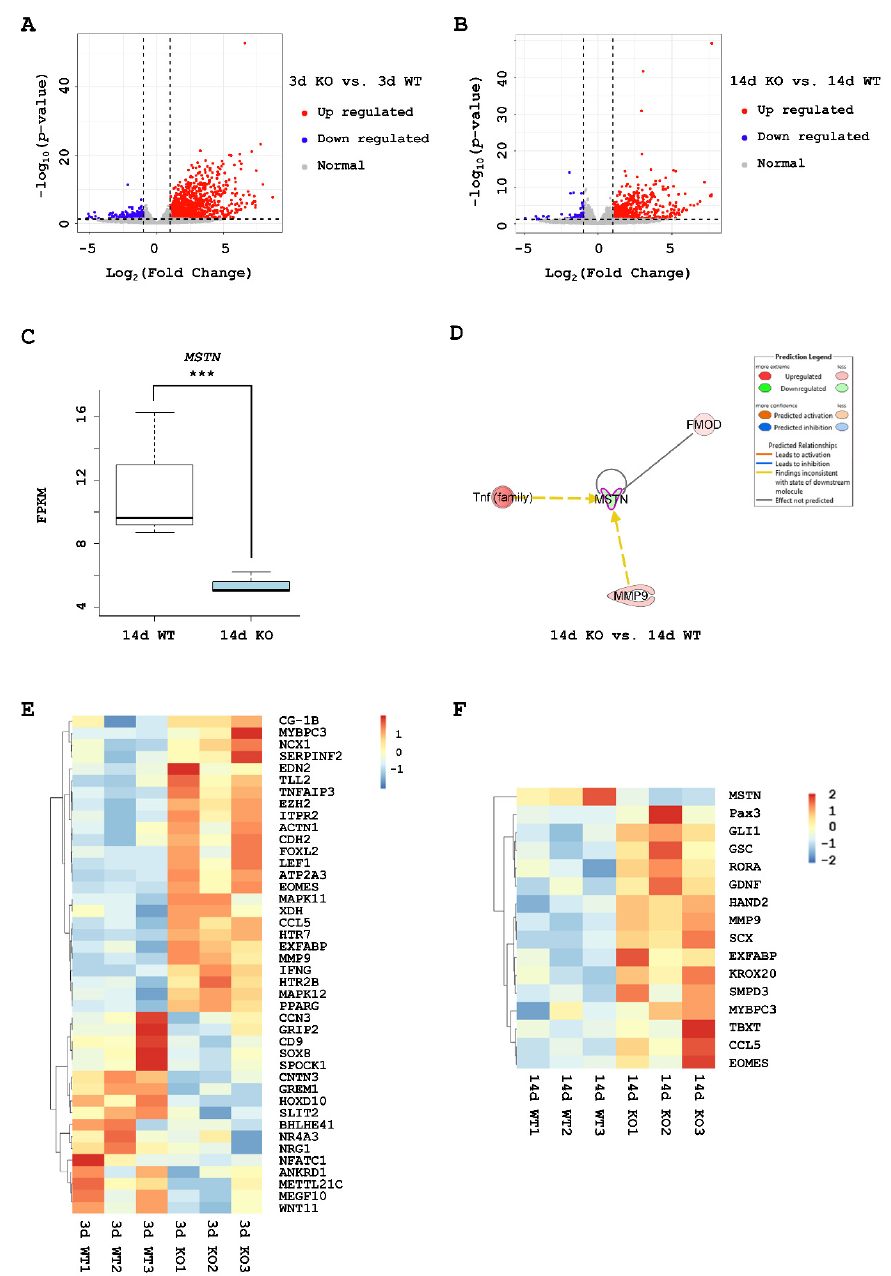
Figure 2. Di ff erentially expressed genes (DEGs) from RNA-Seq data. ( A ) Volcano plot reveals significant di ff erentially expressed genes in the 3d KO vs. 3d wild-type (WT) groups. ( B ) Volcano plot of significant di ff erentially expressed genes of the 14d KO vs. 14d WT groups. *** p -value < 0.001. ( C ) The expression of MSTN in the 14d KO and 14d WT groups. ( D ) DEGs associated with MSTN in the 14d KO vs. 14d WT groups. ( E ) Heatmap hierarchical clustering revealed the DEGs related to skeletal muscle tissue development in 3d KO vs. 3d WT groups. ( F ) Heatmap hierarchical clustering revealed the DEGs related to skeletal muscle tissue development in the 14d KO vs. 14d WT. This result also has some limitations, because the KO groups were injected with AdV-CRISPR, while the WT groups were injected with phosphate bu ff ered saline